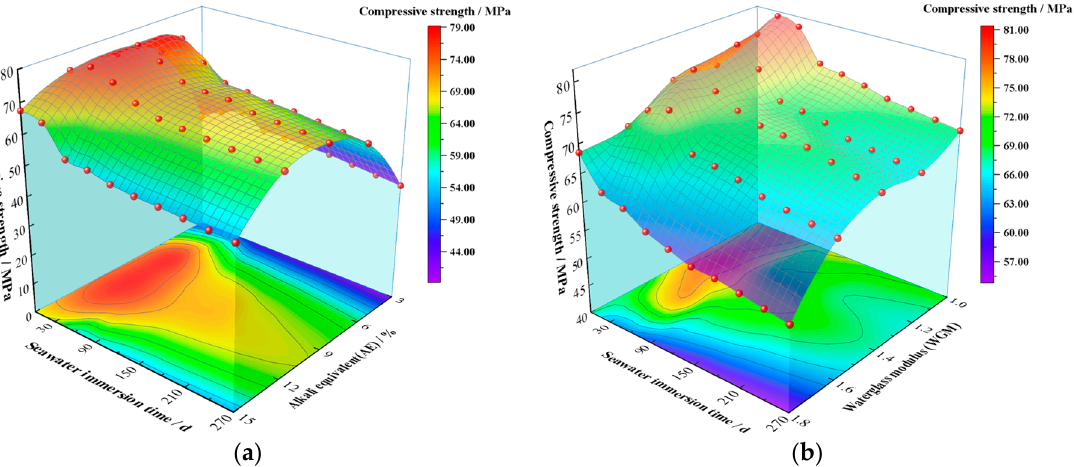
Figure 4. Effect of seawater immersion on the UCS of GPM: ( a ) Effect of seawater immersion time and AE; ( b ) Effect of seawater immersion time and WGM.